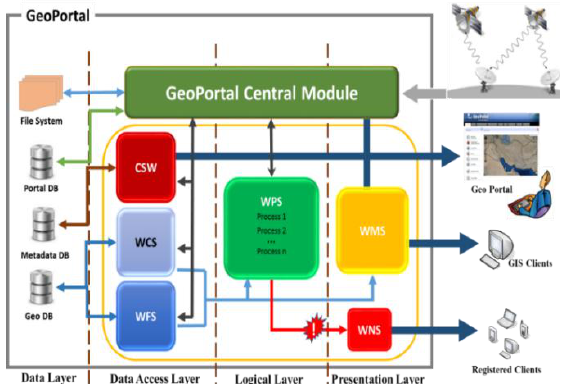
Figure 4. Architecture of fire detection early warning system